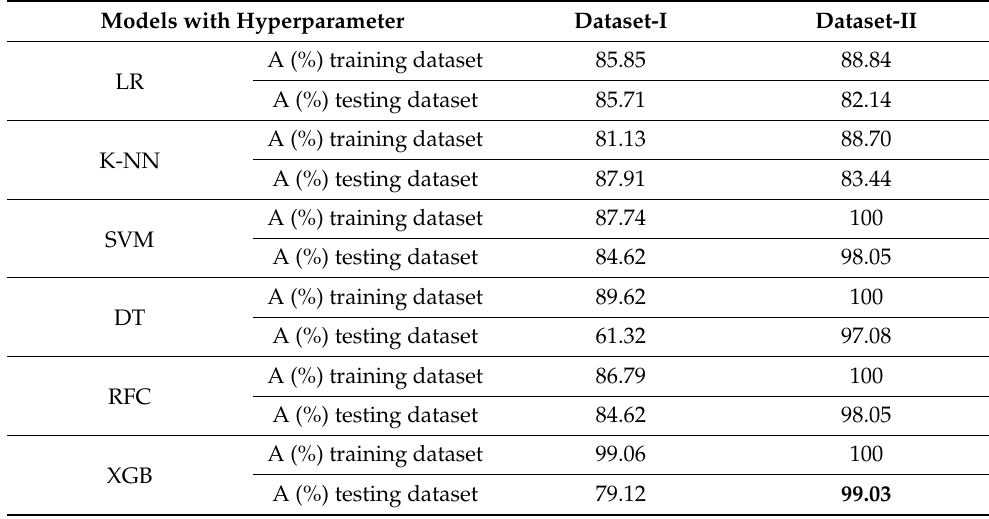
Table A6. Accuracy (A) of the diagnosis of two datasets using six machine learning techniques.